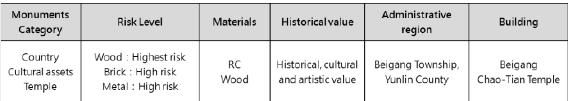
Table 1 、 Monitoring object adopt for Beigang Chao-Tian Temple